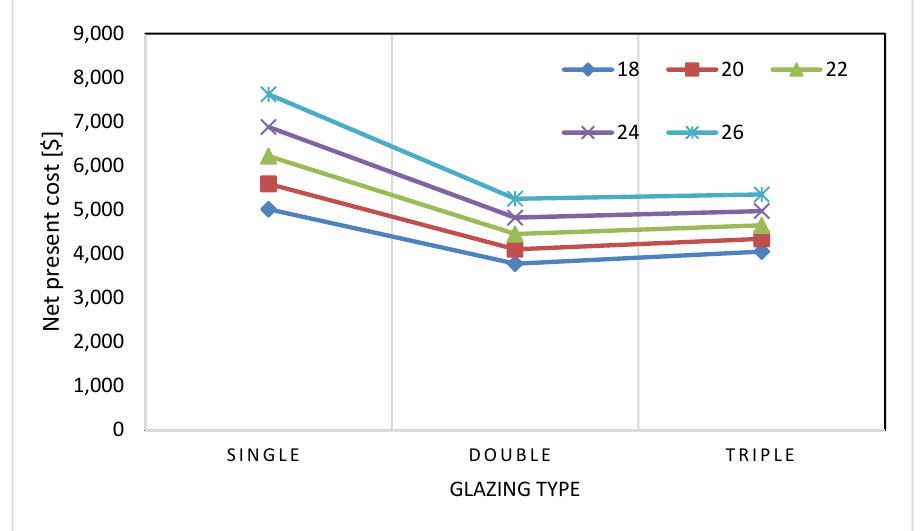
Figure 19. The influence of the heating set-point temperature on the net present cost for Hakkari .